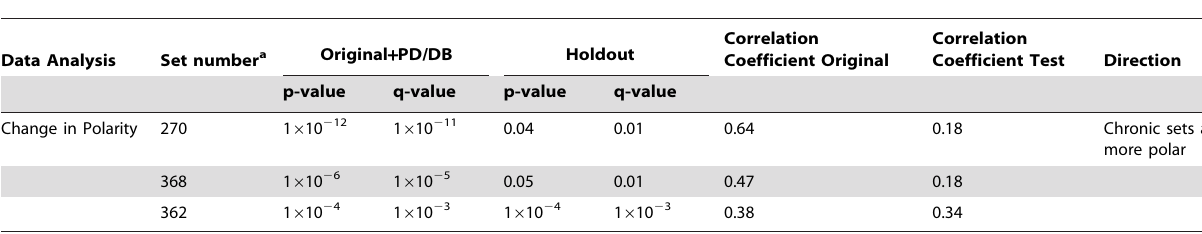
Table 6. Summary statistics regarding changes in regional hydrophobicity associated with chronic